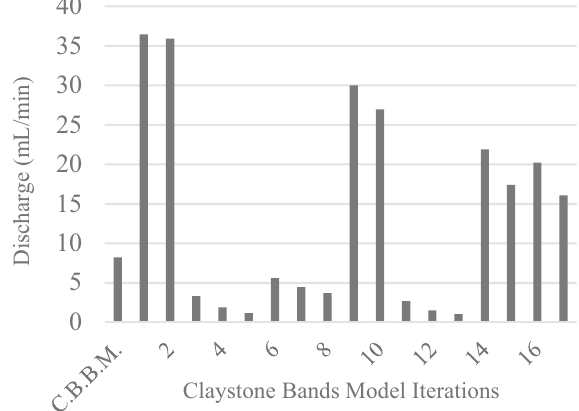
Fig. 8 Partially grouted bolt discharge flow rates for 17 clay band model iterations. C.B.B.M. represents Clay Band Base Model. Description of Clay Band models is listed in Table 2